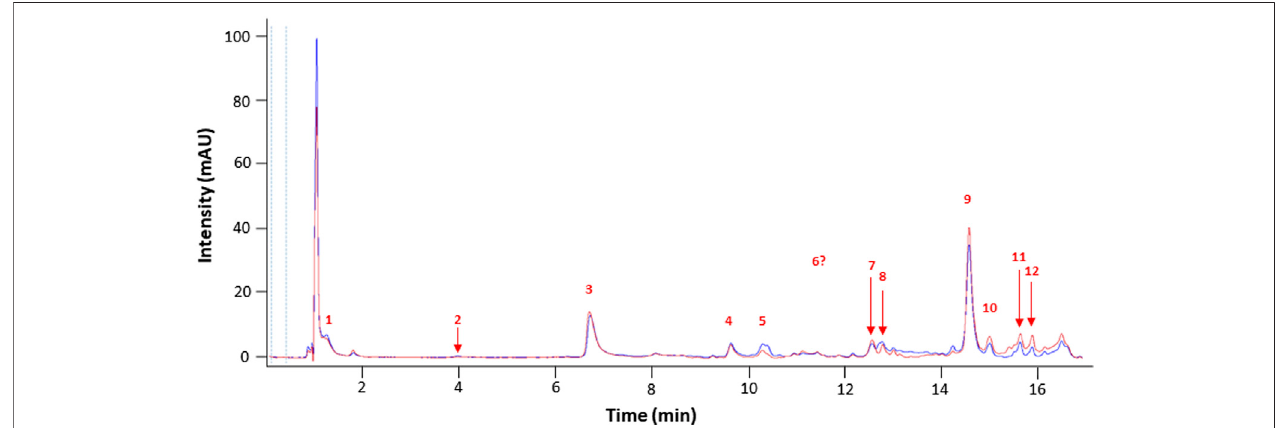
FIGURE 1 | Representative chromatograms of NSP01-TE (blue) and NSP01 (red) H. serrata extracts using UHPLC-DAD at 310 nm. Peak numbers refer to those implemented in Table 1